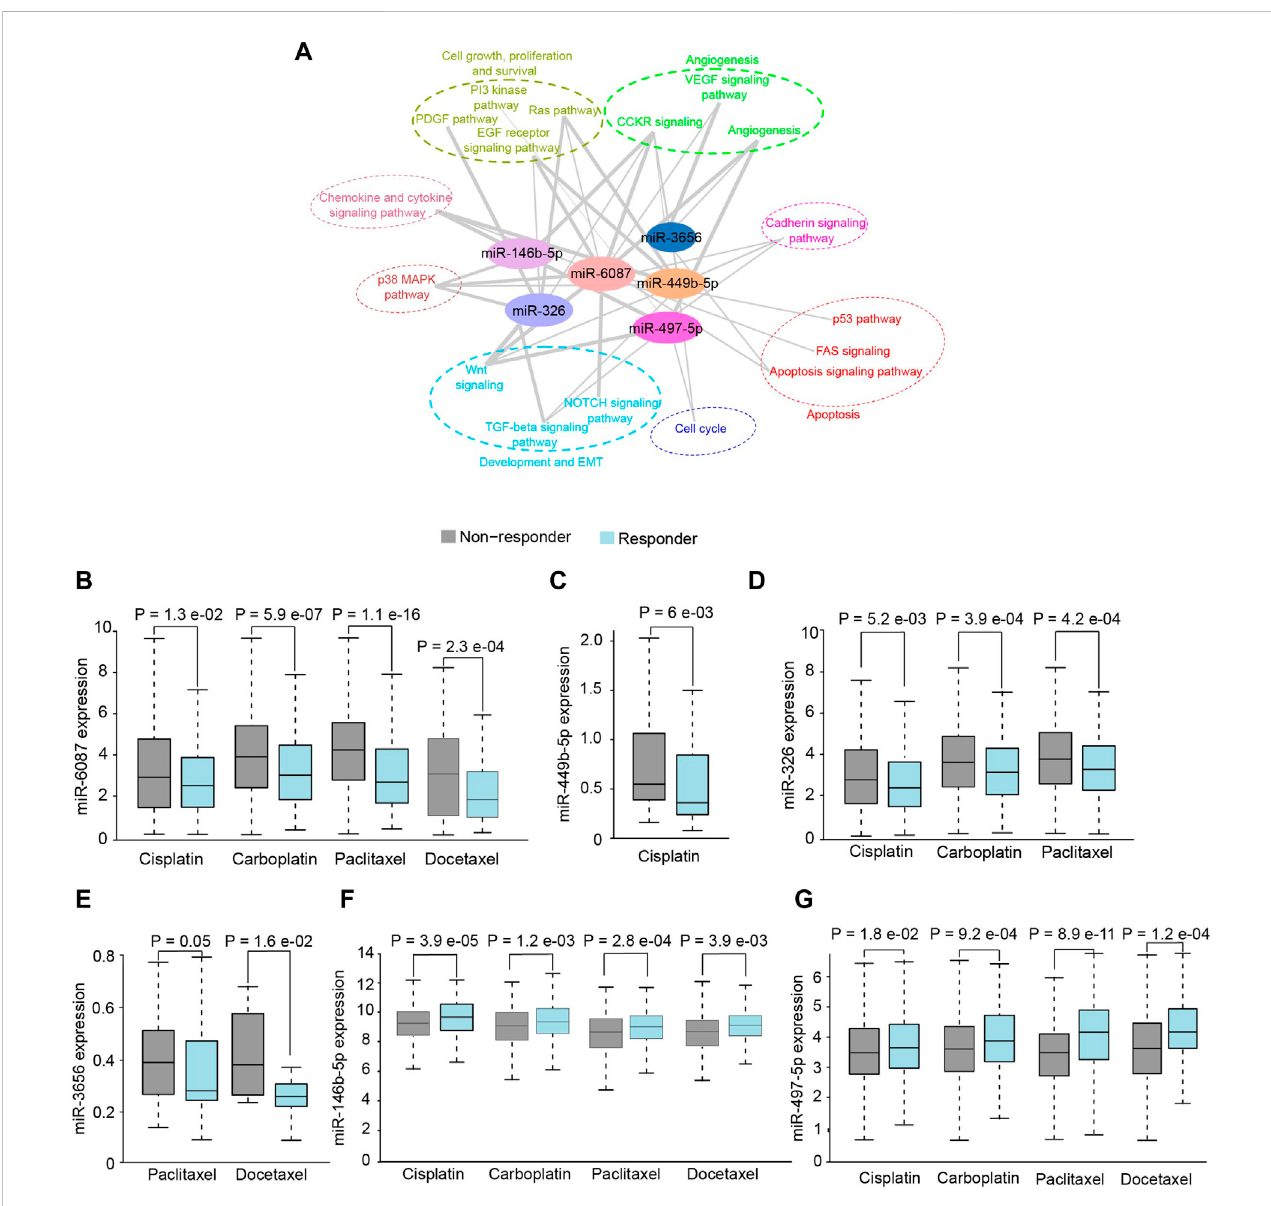
FIGURE 3 Functional analysis of salivary miRNAs. (A) Network analysis depicting association of differentially expressed miRNAs with cancer pathways. (B – G) Response of OSCC patients towards chemotherapeutics drugs with respect to higher expression of miR-6087, miR-449b-5p, miR-326, miR-3656, miR- 146b-5p and miR-497-5p,